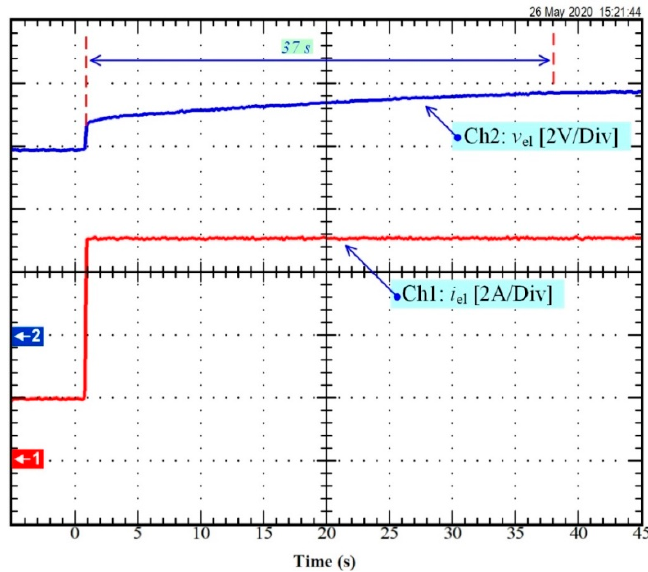
Figure 2. Response of the PEM electrolyzer as a result of a rise current.